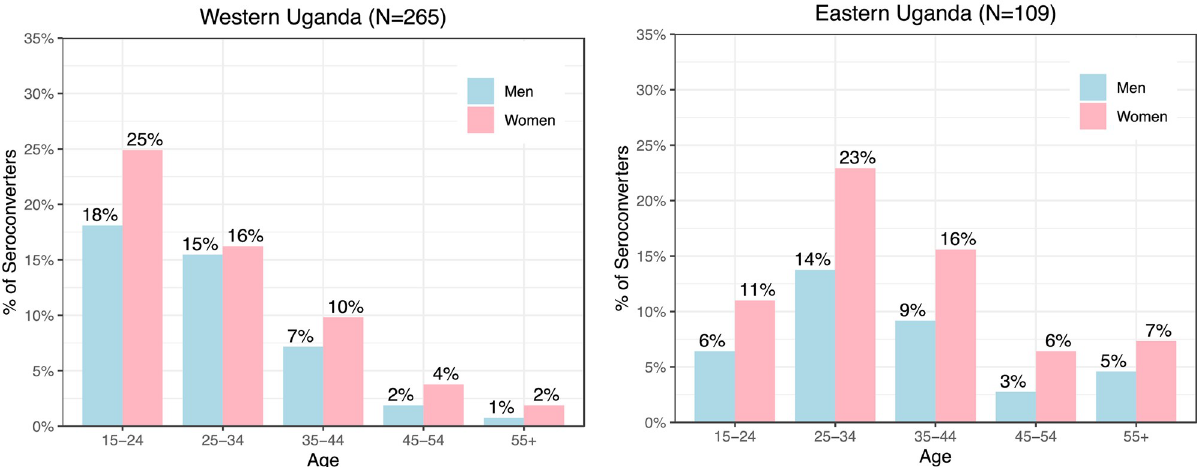
Fig 1. Seroconverters by age group and gender in the SEARCH test-and-treat trial in 3 regions in rural East Africa: Western Uganda, Eastern Uganda, and Kenya. https://doi.org/10.1371/journal.pone.0243167.g001 Table 2. Gender-specific HIV incidence rates per 100 person-years (95% confidence intervals) in SEARCH trial (2013–2017) in rural Kenya and Uganda. Seroconversion